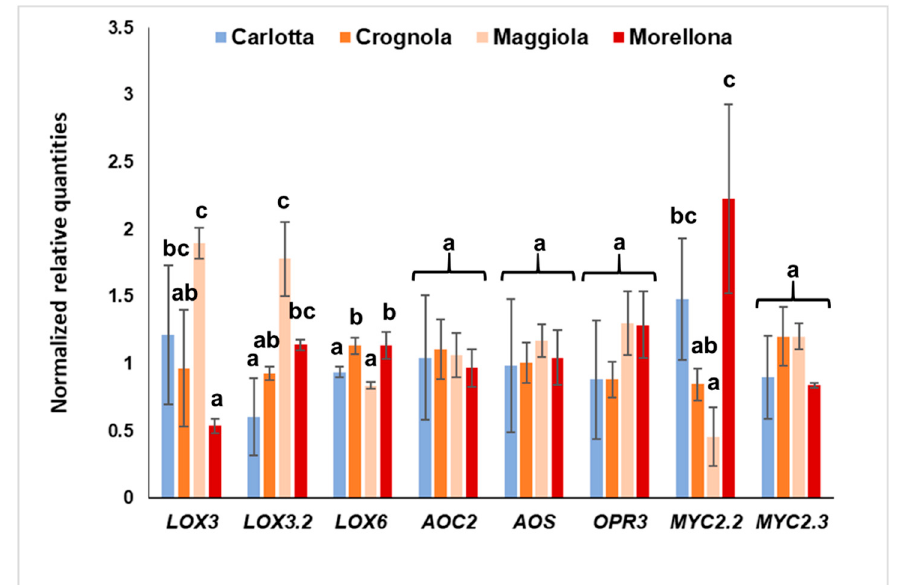
Figure 3. Relative expression of JA biosynthetic genes in the four Tuscan varieties. Error bars refer to the standard deviation (number of independent biological replicates = 4). Different letters indicate statistically significant differences among the groups of the one-way ANOVA with Tukey’s post-hoc test.